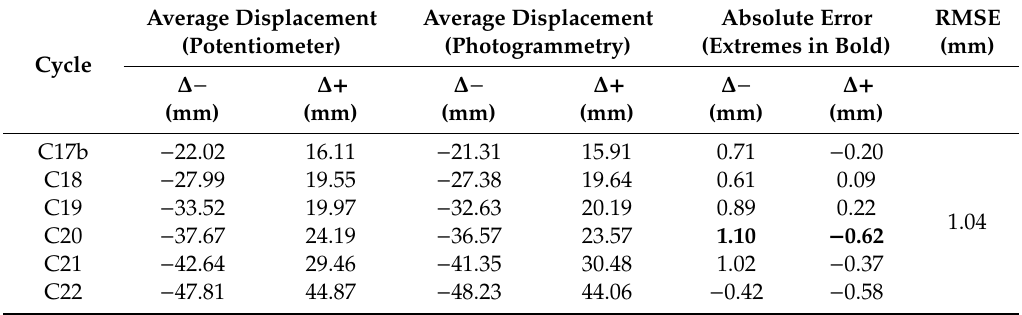
Table 8. Absolute errors obtained for the comparison between the average values of the peaks captured by target 1134 and sensor P2 after outlier